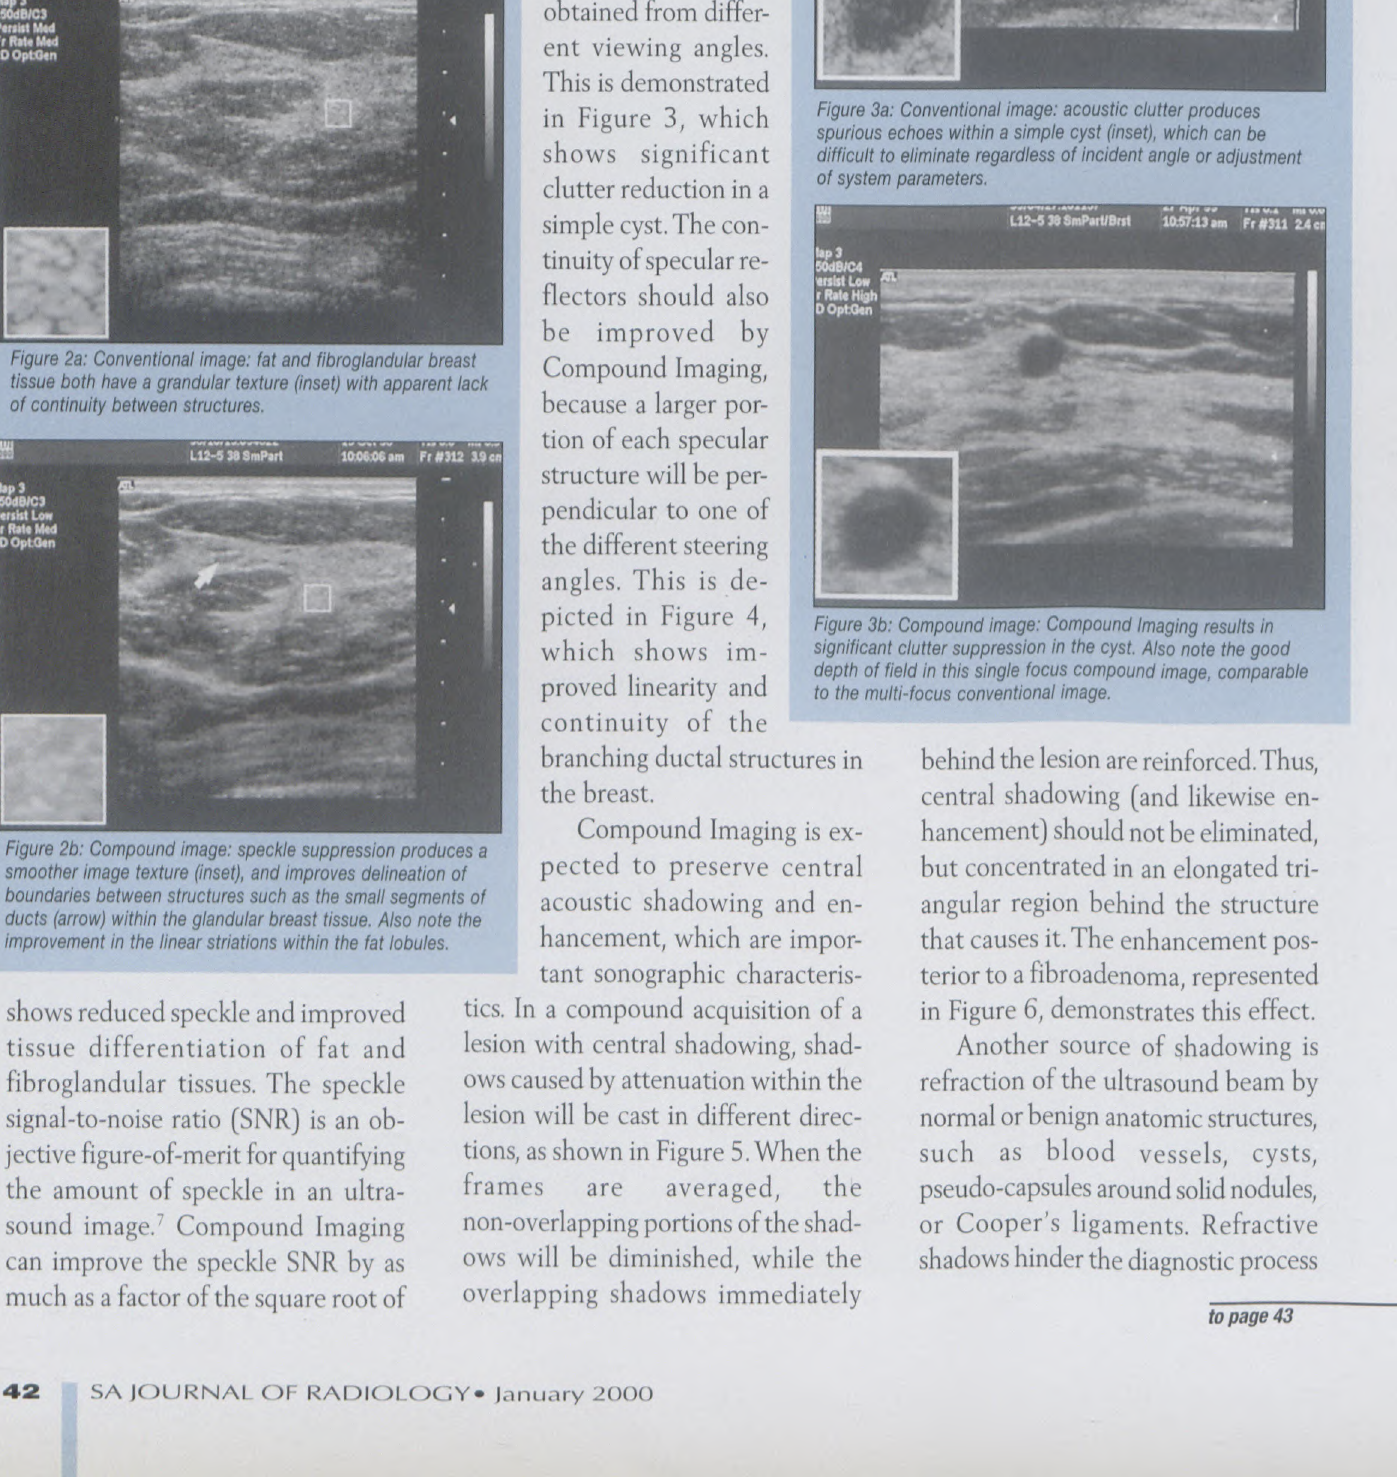
Figure 3a: Conventional image: acoustic clutter produces spurious echoes within a simple cyst (inset), which can be difficult to eliminate regardless of incident angle or adjustment of system parameters.